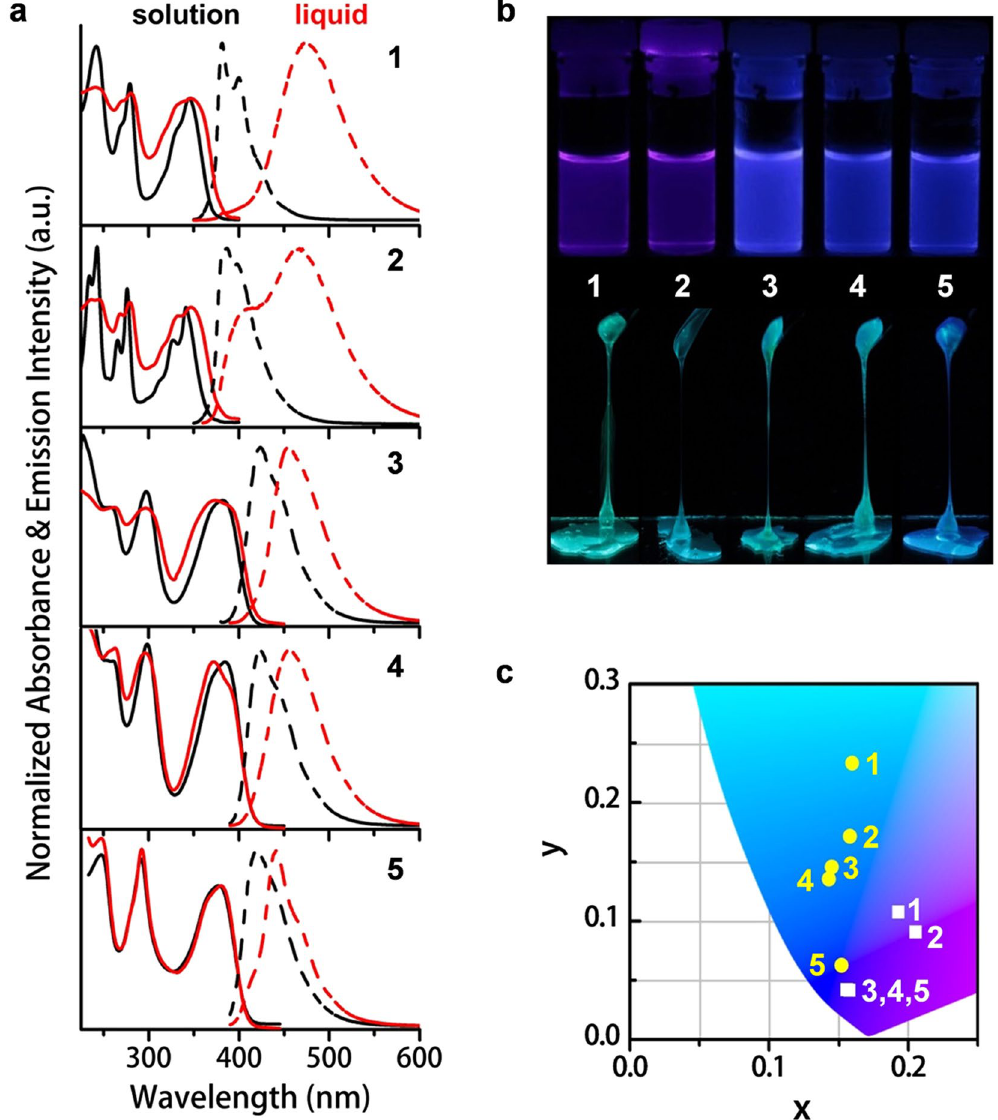
Figure 4. Photophysical properties of 1 – 5 in solution and solvent-free liquid state. ( a ) Normalized UV-vis absorption (solid lines) and fluorescence (dashed lines) spectra of 1 – 5 in solution (black) (UV-vis: 10 μ M; fluorescence: 1 μ M) and solvent-free liquid state (red) at 25 °C. Solvent: 2 , n -hexane; others, dichloromethane. The liquid samples were sandwiched between two quartz plates. λ ex : 1 and 2 , 344 nm; 3 , 4 and 5 , 378 nm. ( b ) Photo images of solution (top) and liquid (bottom) samples under handy UV lamp irradiation at 365 nm. ( c ) A section of CIE 1931 chromaticity diagram of 1 – 5 in both solution (white squares) and liquid state (yellow circles) at 25 °C. Only liquid 5 exhibits similar luminescent color to its solution, while liquids 1 – 4 showed different emission colors to their